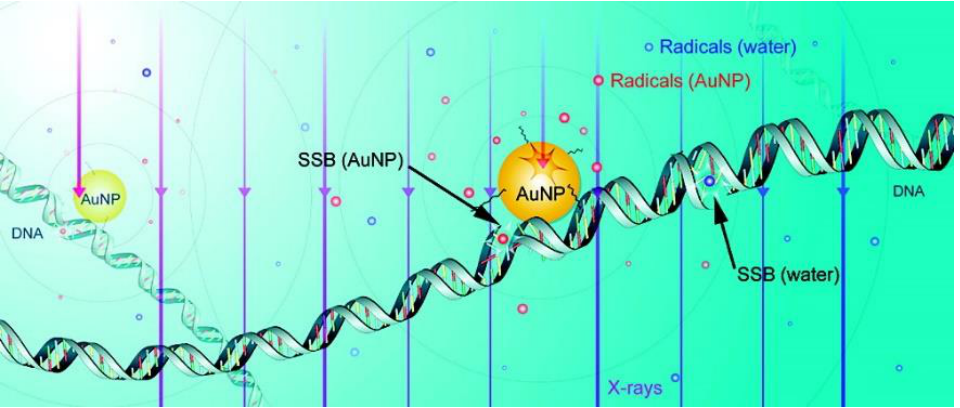
Figure 4. Schematic showing chemical mechanism of GNP radiosensitization. Reproduced with permission from [42], American Chemical Society, 2017.